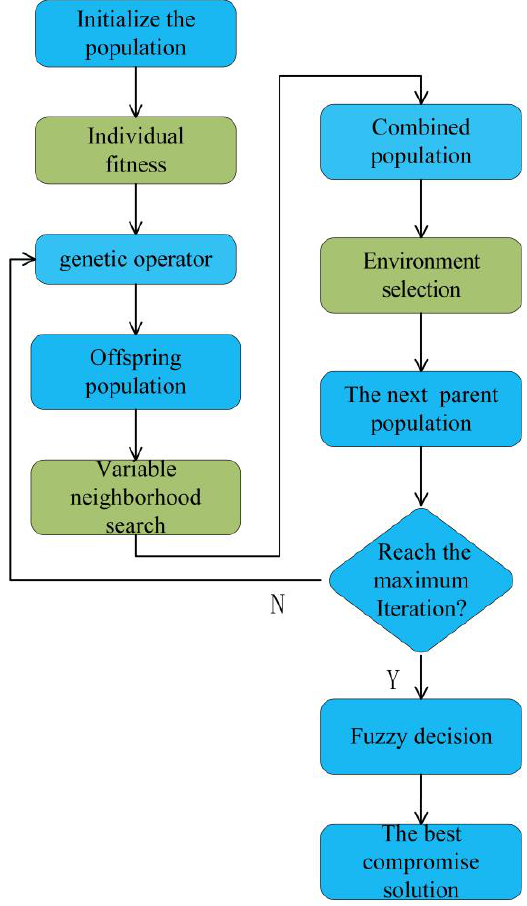
Figure 1. The flowchart of SV-MA method.